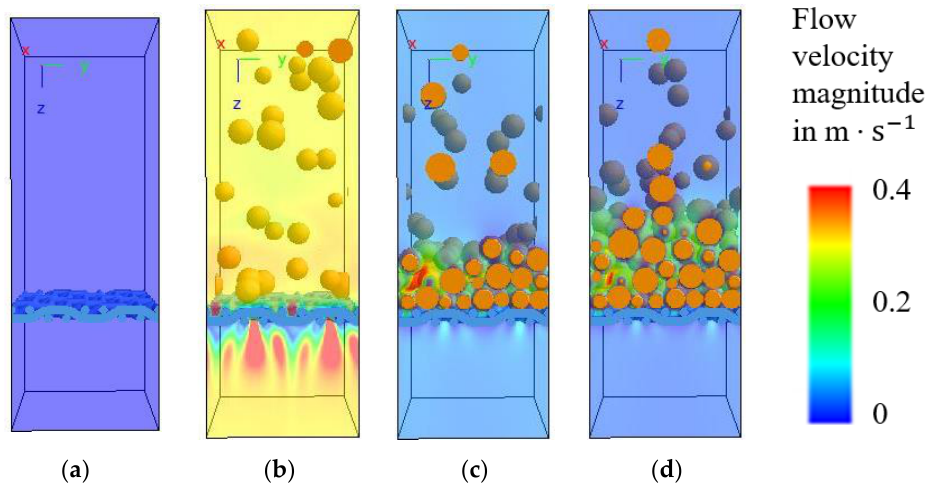
Figure 18. CFD-DEM simulation of the filtration process with the woven wire cloth filter medium ( a ) filter medium model, before the process starts at 𝑡 = 0 ms, ( b ) inflowing suspension at 𝑡 = 3.9 ms, ( c ) particles are retained by the filter medium 𝑡 = 40 ms, ( d ) filter cake formation at 𝑡 = 98 ms.